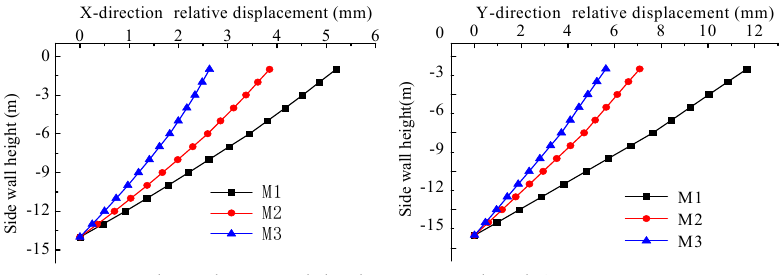
Table 6. Soil elasticity modulus (MPa). Number